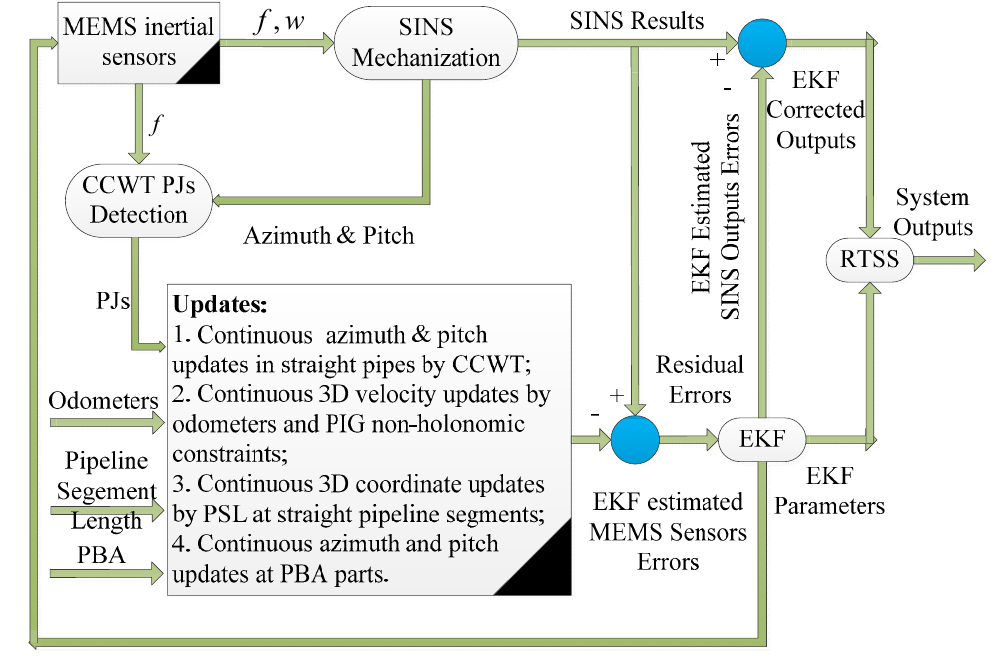
Figure 11. Schematic of SINS/Odo/PJ/PSL/PBA-based intelligent PIG surveying technology.